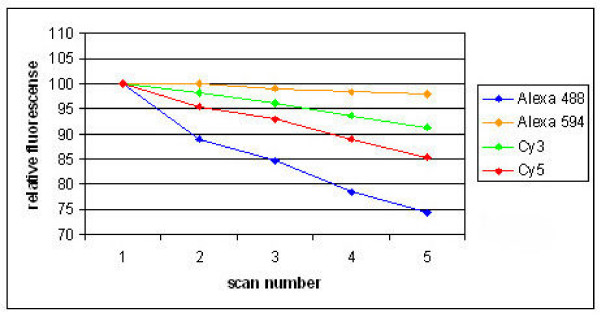
Photo bleaching of Alexa 488, Alexa 594, Cy3 and Cy5 after repetitive scanning of the microarray. Mean signal intensity of Alexa 488, Alexa 594, Cy3 and Cy5 is presented after repetitive scanning, relative to the signal at the first scan.